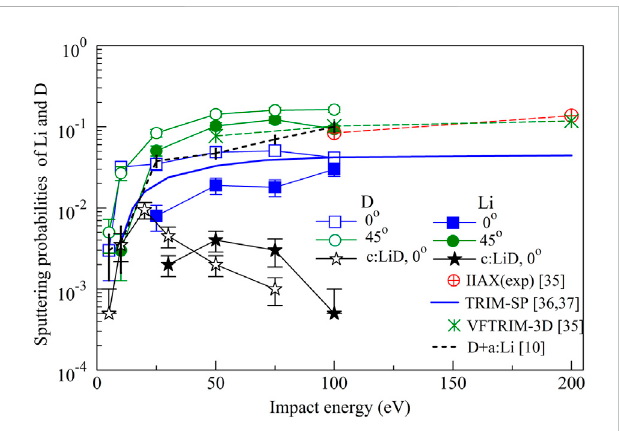
FIGURE 4 Sputtering probabilities of Li and H atoms per impact of H in the range of impact energies 1 – 100 eV, for various angles of incidence θ on an a:LiH surface at 300 K. Results are also shown for Li sputtering from an a:Li surface upon the impact of H at various θ [9].